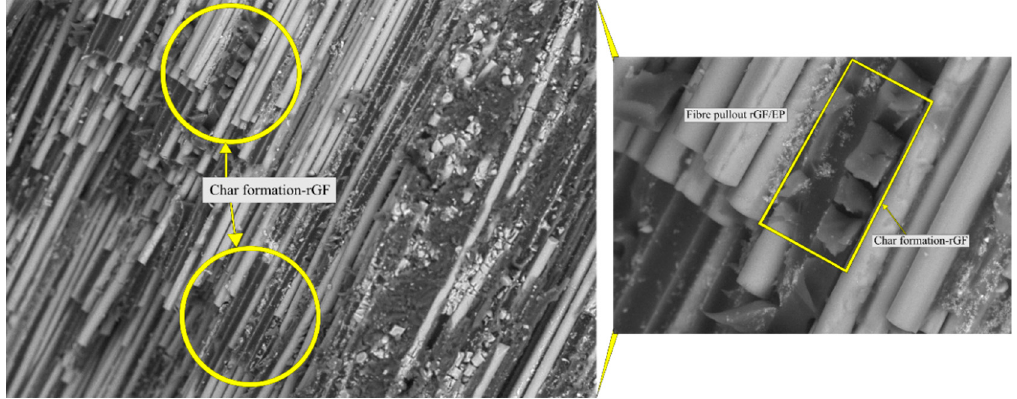
Figure 12. Presence of char formation in rGF/EP composite.